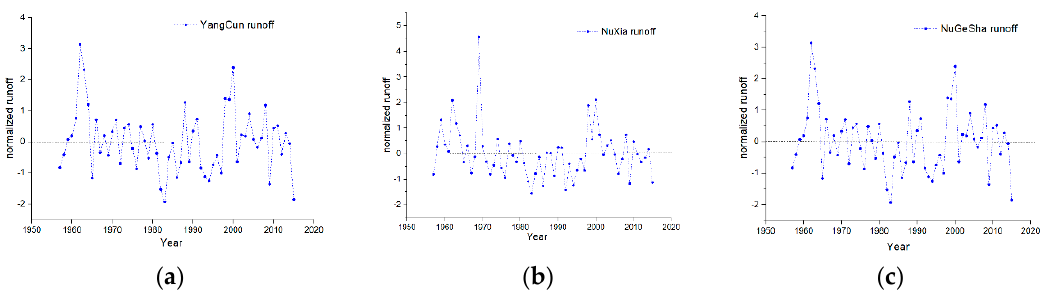
Figure 8. Streamflow trends for selected stations: ( a ) Yangcun station, ( b ) Nuxia station, and ( c ) Nugesha station in the YLZR basin during 1957–2015.